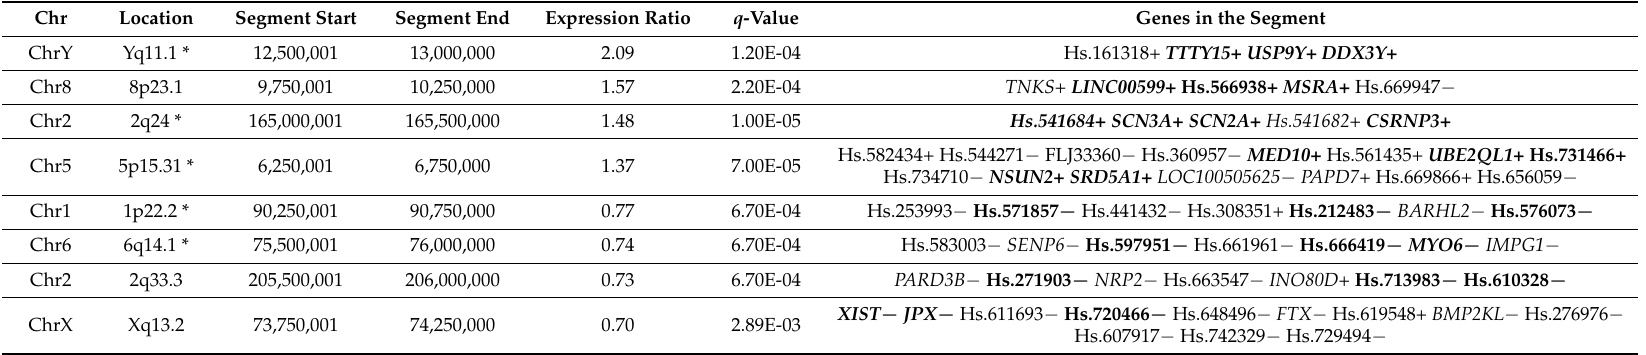
Table 2. Chromosomal segments statistically significant in TRAM “Map” mode analysis of male substantia nigra (SN) control samples vs. female SN control samples (TRAM